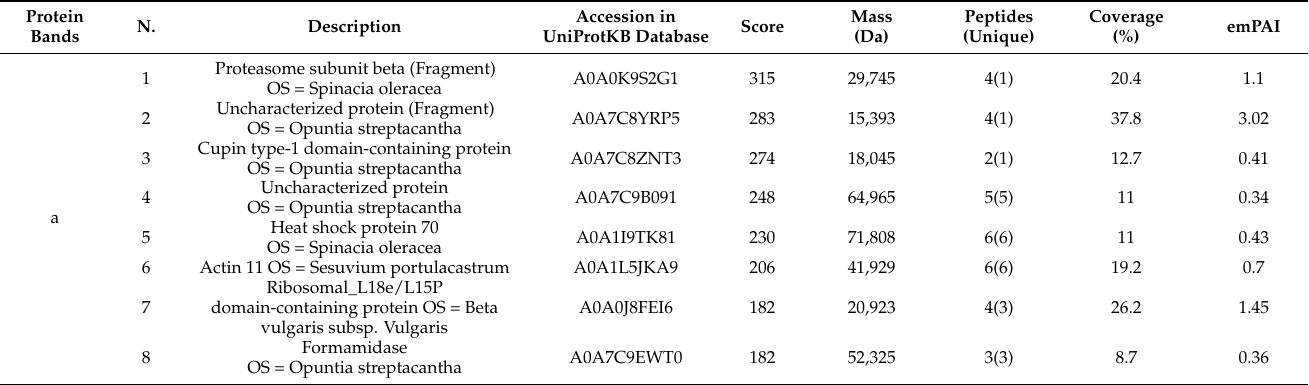
Table 2. Top 10% of protein identified by LC–MS/MS in excised gel spot from red-fleshed pitaya